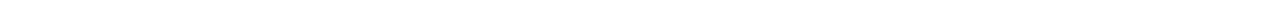
Fig. 3 The cochlear stria vascularis accumulates high levels of cisplatin, resulting in its dysfunction. a A cross-sectional illustration of cochlear architecture. The three regions of the cochlea: stria vascularis, organ of Corti and spiral ganglion, microdissected for ICP-MS analysis are indicated by dashed red lines. Endolymph fi lls the blue shaded region. IHC inner hair cell, OHC outer hair cell. b Platinum concentrations in microdissected cochlear regions in the fi rst 24 h following a single i.p. injection of cisplatin. Cisplatin readily distributes throughout these cochlear regions within the fi rst hour. Platinum concentrations are normalized to sulfur content, a surrogate for total tissue quantity 51 . n = 3 – 4 mice per time point. Statistical signi fi cance is displayed for stria vascularis values as compared to the other two cochlear regions. Two-way ANOVA followed by the Holm – Š idák multiple comparisons test was used to determine signi fi cance. c Concentrations of platinum in cochlear regions throughout the complete cisplatin regimen. Platinum progressively accumulates in all three regions, but most signi fi cantly in stria vascularis. n = 3 mice per time point. Statistical signi fi cance is displayed for stria vascularis values as compared to other two regions. Two-way ANOVA followed by the Holm – Š idák multiple comparisons test was used to determine signi fi cance. d Concentrations of platinum in cochlear regions at the end of the cisplatin regimen and following a subsequent 60-day recovery. All regions show a decrease in platinum concentrations. n = 4 mice per group. Unpaired two-tailed t- tests were used to determine signi fi cance. e Representative low-magni fi cation confocal slices from cochlear cryosections of mice treated with a full regimen of BODIPY FL-cisplatin or the control (no cisplatin) conjugate BODIPY FL-Boc. SG spiral ganglion, OC organ of Corti, SV stria vascularis, IS interscalar septum. Scale bar = 100 µ m. f Representative maximum intensity projections of thin confocal stacks of the stria vascularis only. Scale bar = 50 µ m. g Representative maximum intensity projections of confocal stacks of organ of Corti whole mounts. Scale bar = 25 µ m. h Endocochlear potentials (EPs) measured in the endolymph following cisplatin treatment. EPs decline at 24 h after cisplatin but recover somewhat by the end of the regimen. However, 60 days after cessation of cisplatin administration, EPs are still signi fi cantly reduced. n = 3 – 6 mice per group; data points represent individual mice. Unpaired two-tailed t- tests were used to determine signi fi cance. Data are expressed as mean ± s.e.m. ns